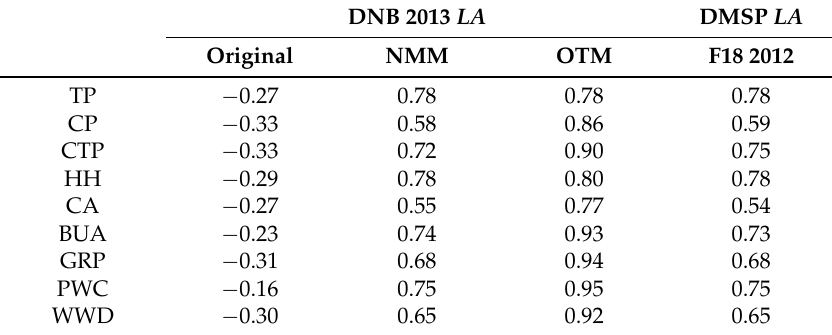
Table 5. Correlation coefficients between LA and socio-economic parameters. LA ’s are derived from DNB composite data with or without noise filtering and DMSP-OLS F18 stable data,